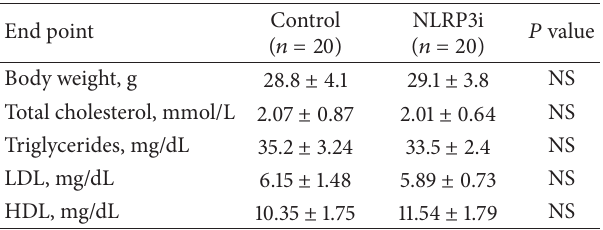
Table 2: Body weight and serum lipid levels in control group and NLRP3i